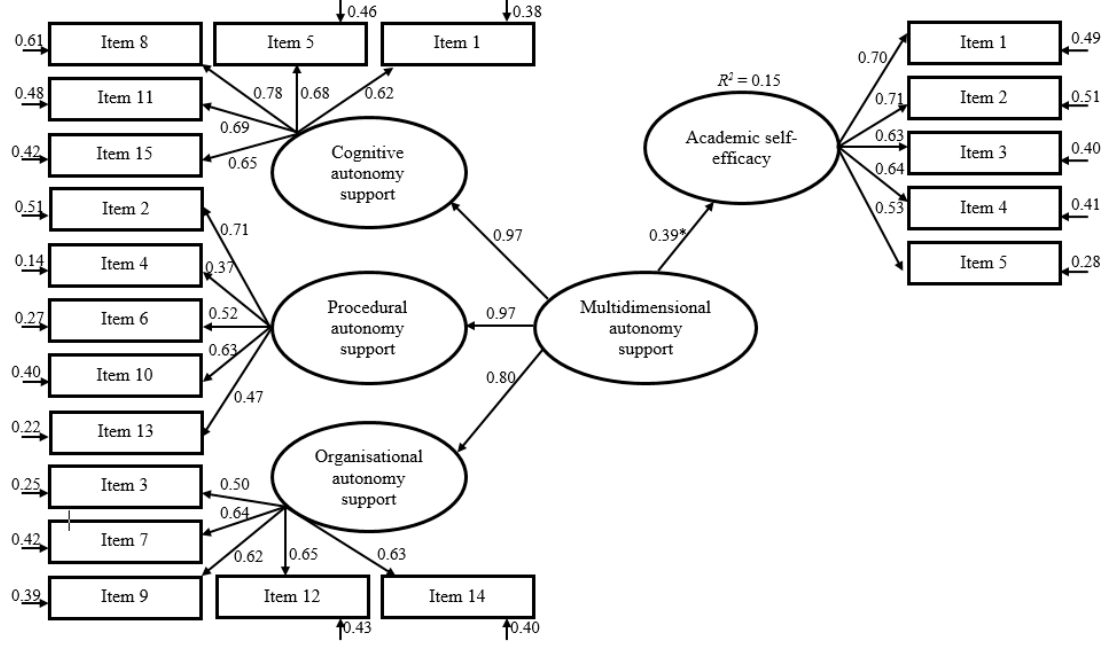
Figure 2. Structural equation modelling to predict academic self-efficacy in physical education (PE) from the latent multidimensional autonomy support of PE teachers. Including standardized regression weights. Regression weight of academic self-efficacy on multidimensional autonomy support is statistically significant ( p < 0.001). R 2 = coefficient of determination.